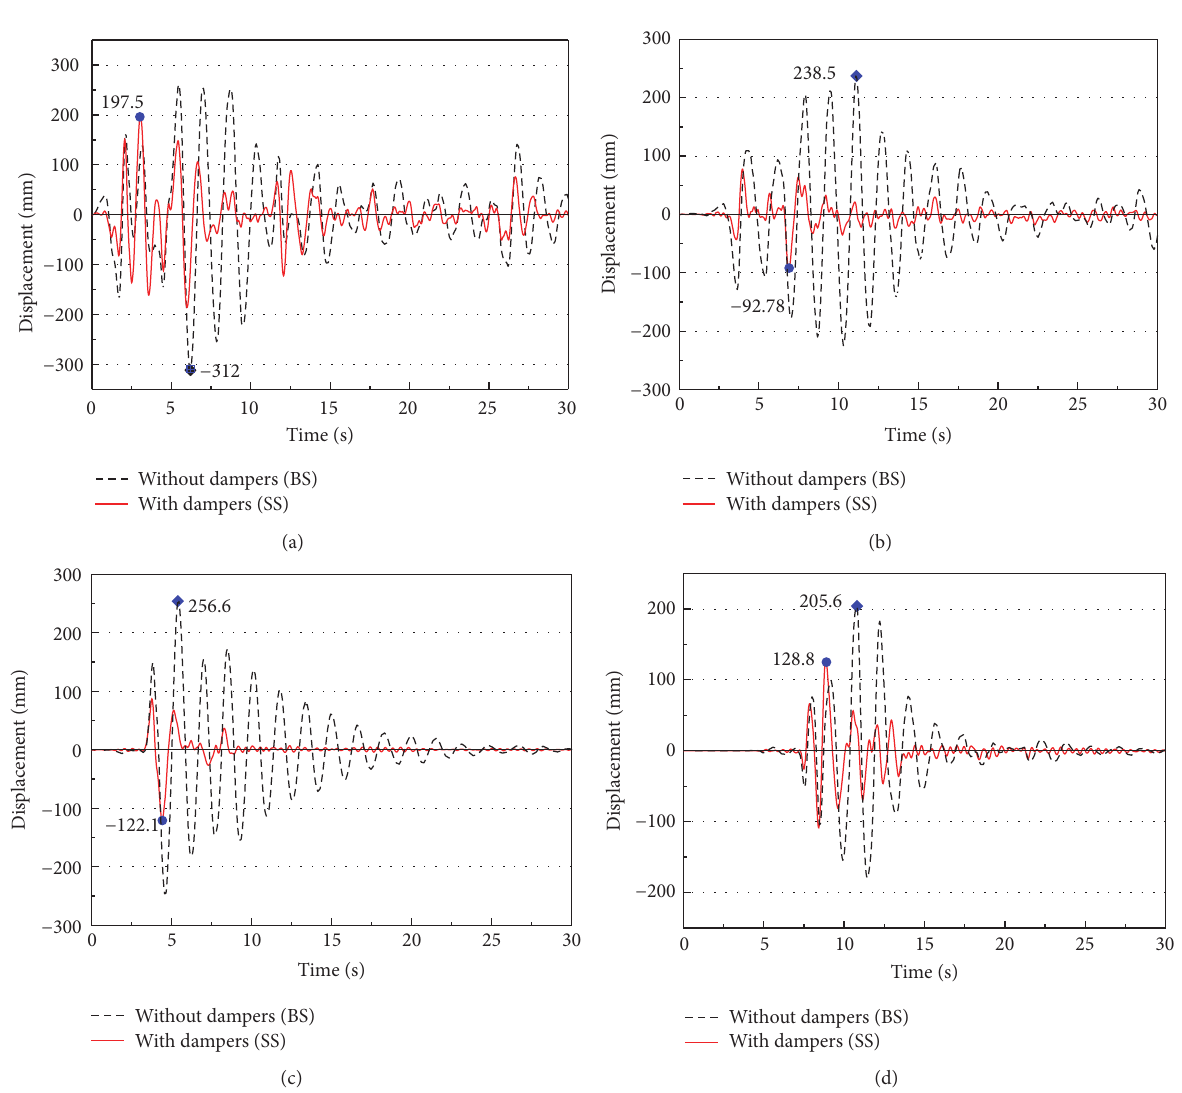
Figure 14: Time-history response of displacement at the top of the portal leg of Models BS and SS for PGA = 0.4 g: (a) El Centro, (b) Taft EW, (c) Northridge EW, and (d) Kobe